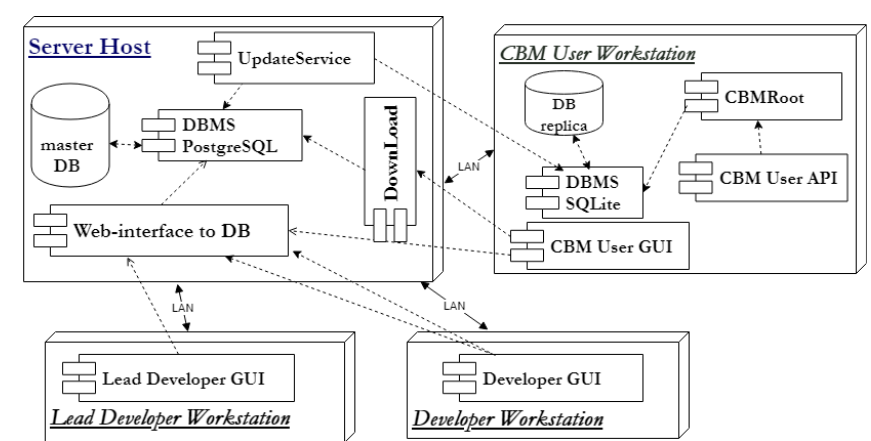
Fig. 4. General architecture of the Geometry